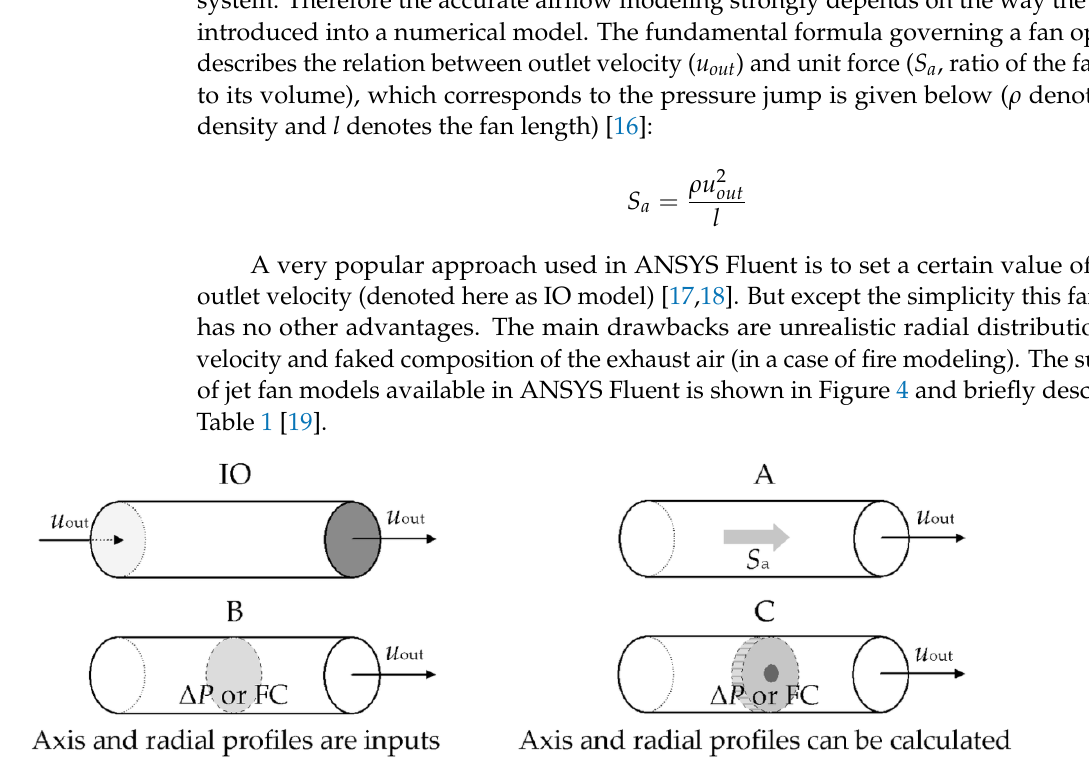
Figure 4. Jet fan available in ANSYS Fluent ( Δ P and FC denote pressure jump and fan curve respectively) [19]. Table 1. A brief description of fan models, based on [19].